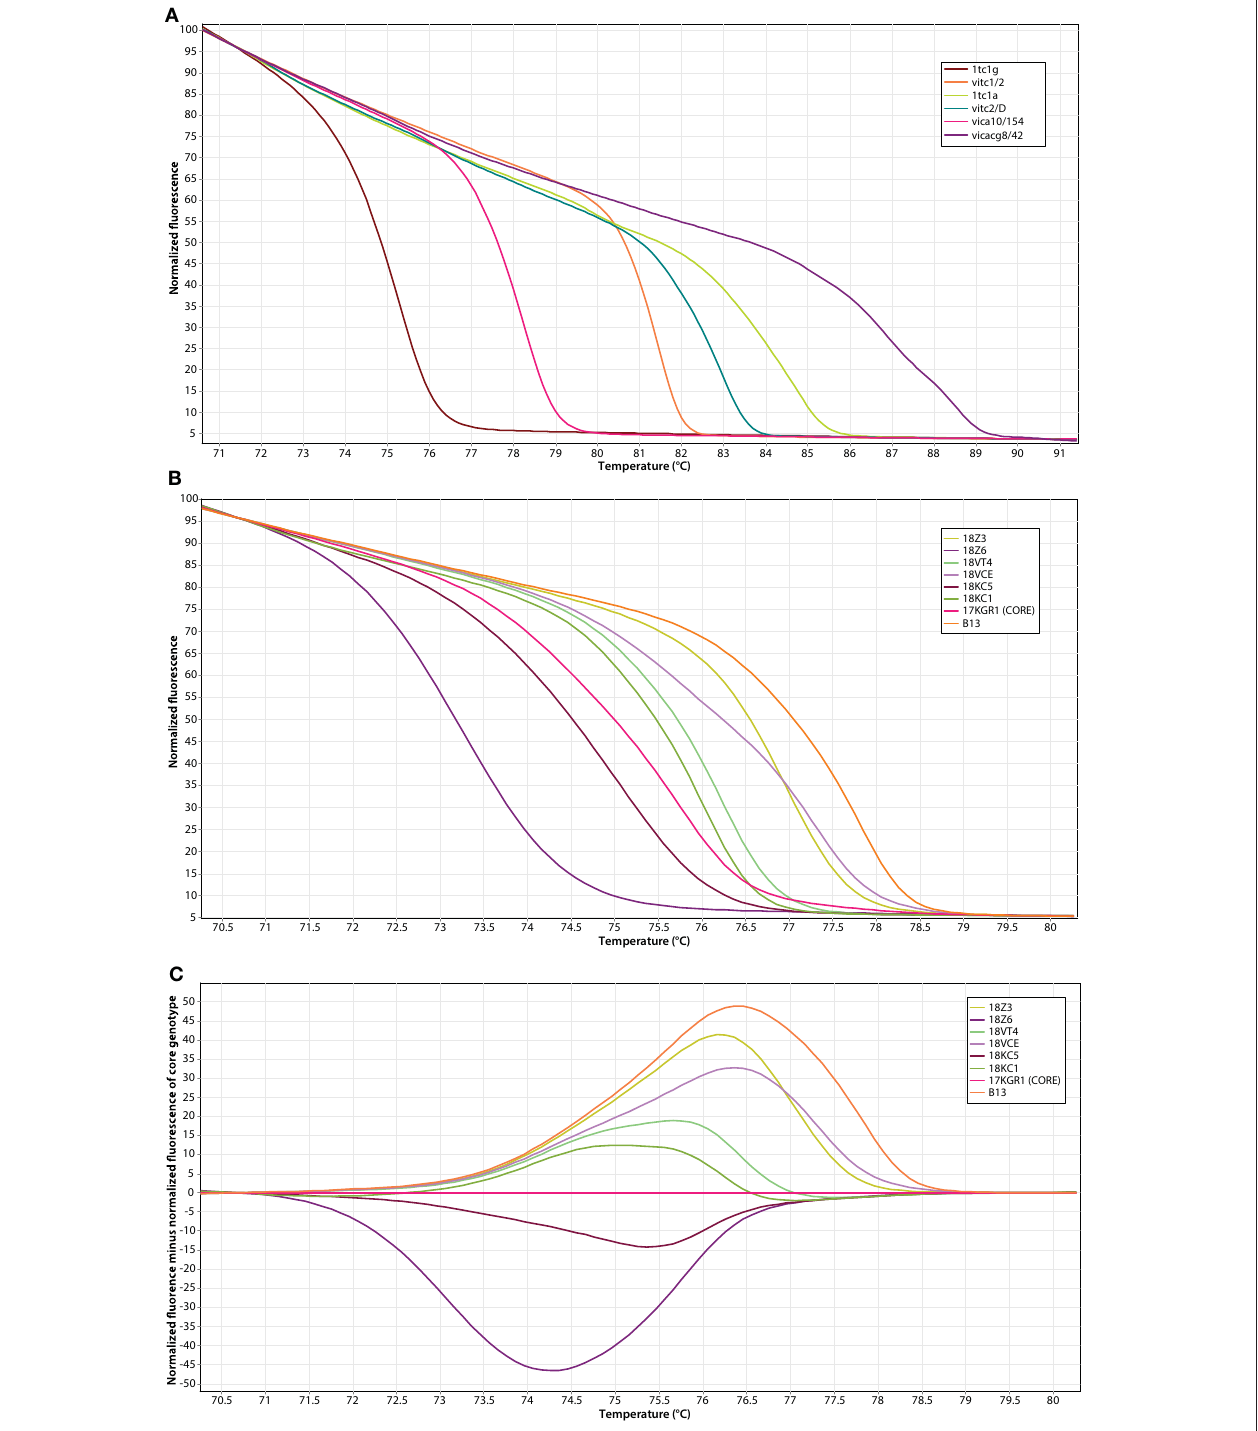
FIGURE 1 | Discrimination of V. inaequalis genotypes using six SSR markers and high resoultion melting (HRM) analysis. (A) HRM profiles of the core genotypes analyzed with the markers 1tc1g, 1tc1a, vitc1/2, vitc2/D, vica10/154, and vicacg8/42. (B) Normalized HRM melting curves of eight unique genotypes using the microsatellite marker 1tc1g. (C) Difference graph of those eight unique genotypes using the 17KGR1 as the reference genotype.